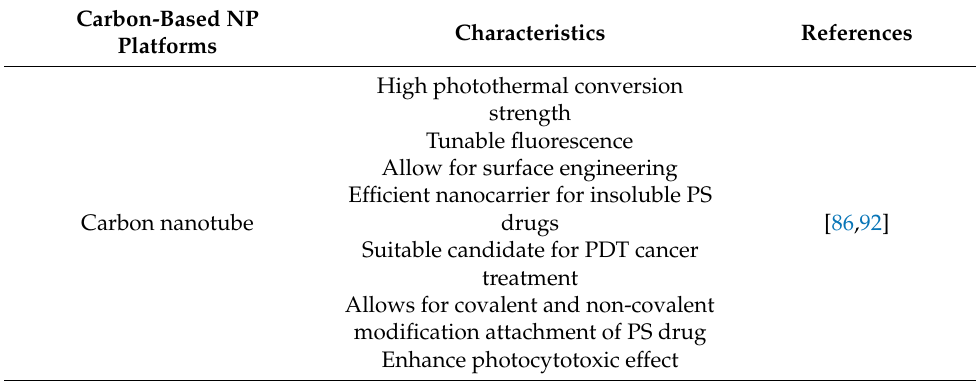
Table 3. Carbon-based NP platforms and characteristics applied for targeted PDD and